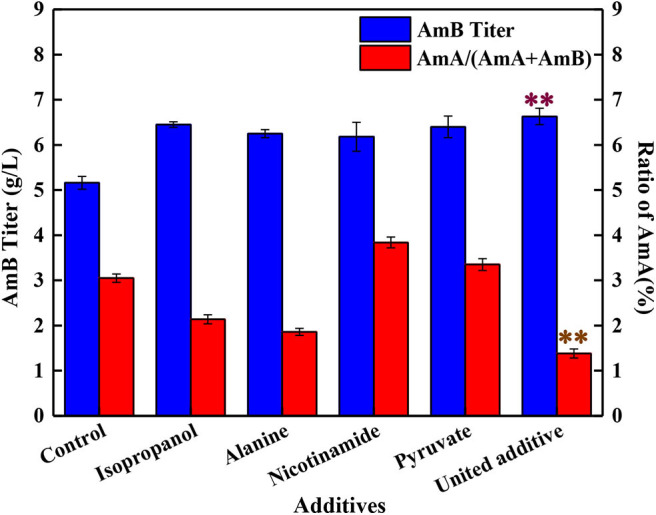
Effects of different addition strategies on the production of AmA and AmB, including the separate addition of isopropanol, alanine, nicotinamide, and pyruvate and the supplementation of united additives. Double asterisk symbols represent the optimum additive feeding strategy. The values shown represent the means of three independent experiments and the error bars represent the standard deviations of three values.